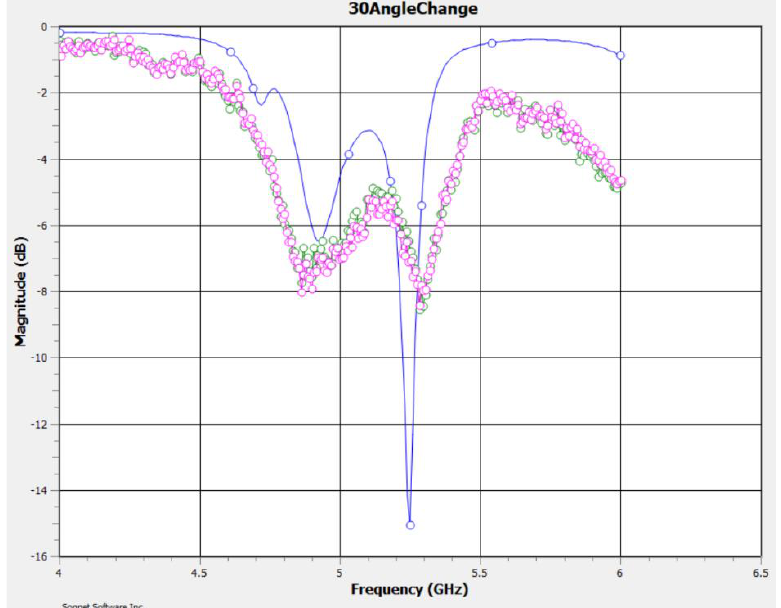
Figure 10. simulated (blue), tested (purple 30°), tested (green